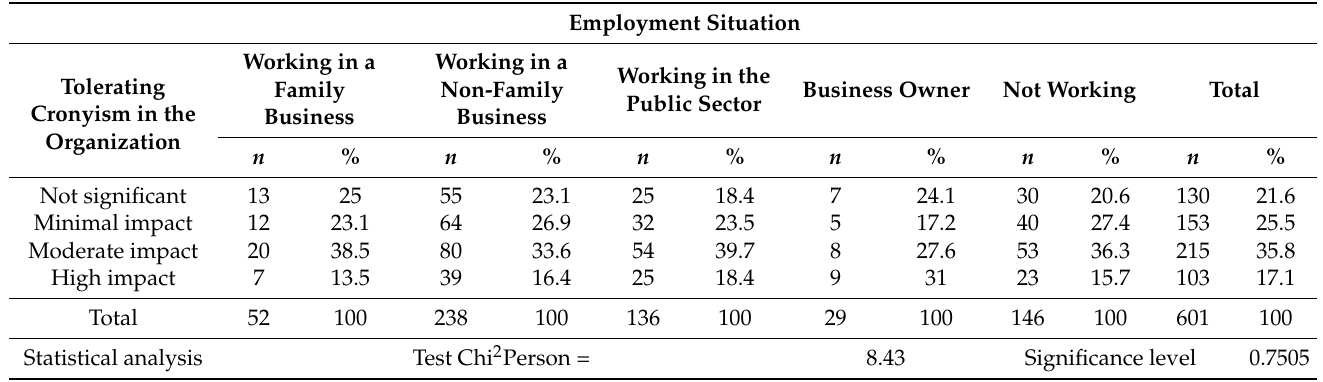
Table 5. Statistical analysis of the assessment of the impact of the Covid pandemic on the tolerance of cronyism depending on the